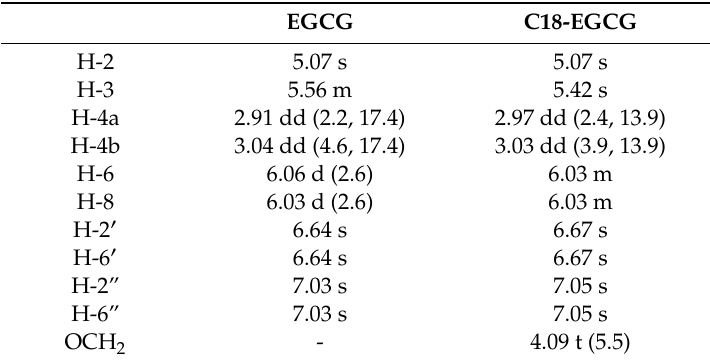
Table 1. 1 H NMR Chemical Shifts a .